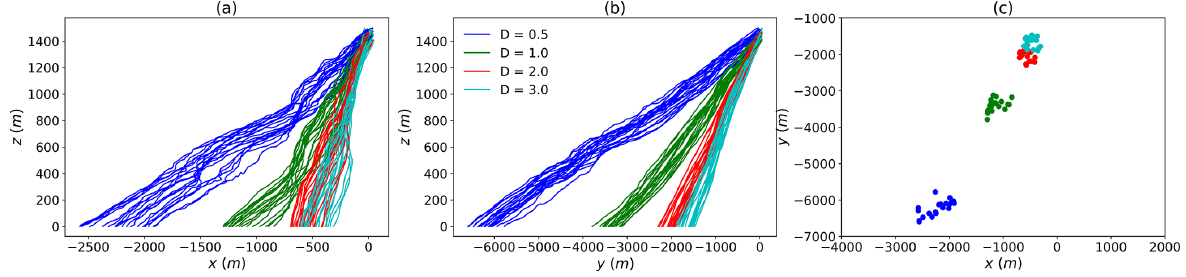
Figure 12. The same as in Fig. 11 but for the strong wind